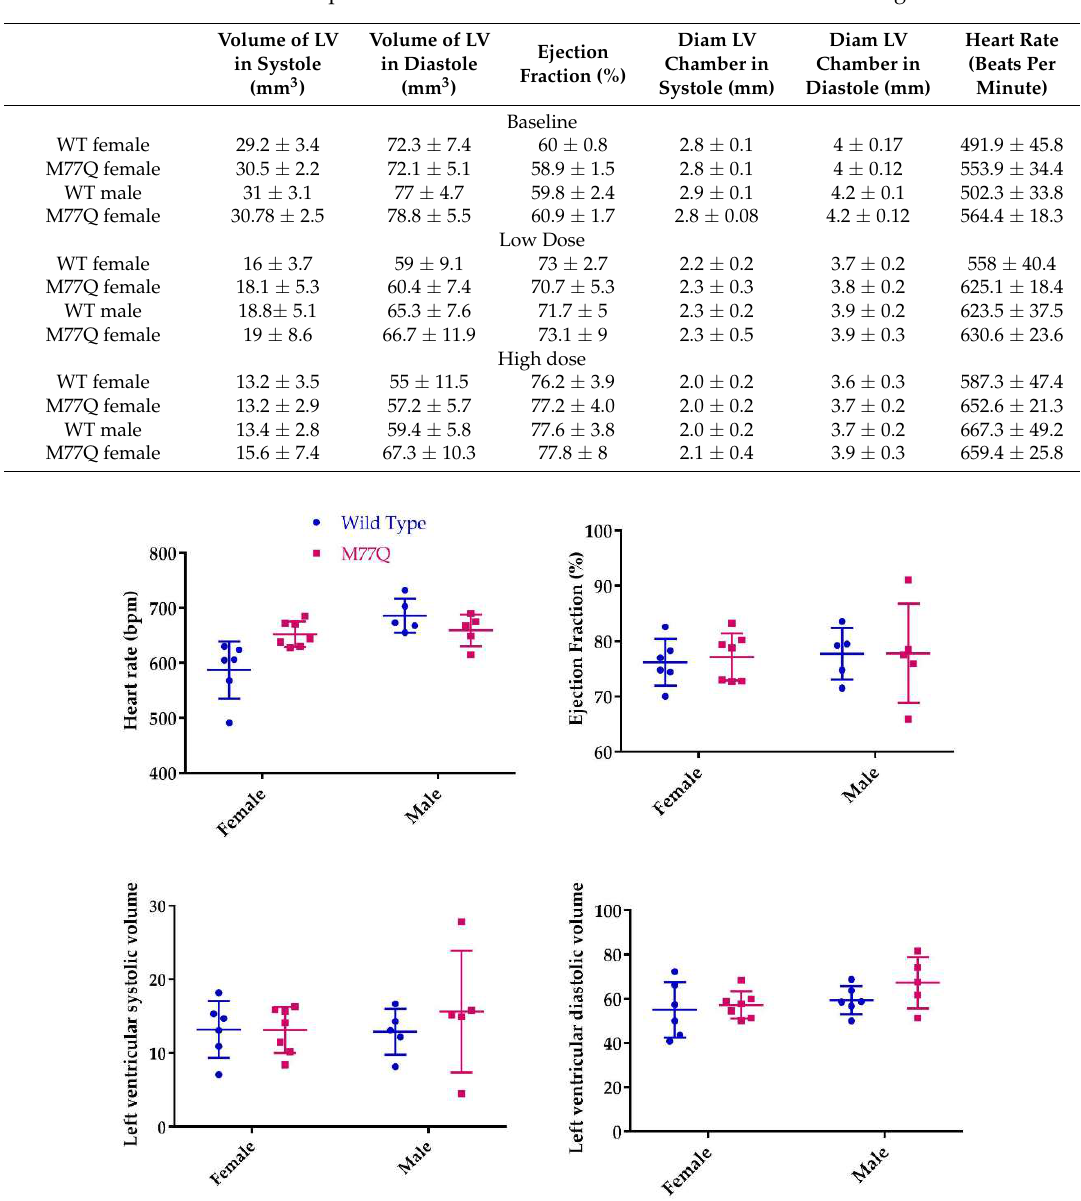
Table 1. Cardiac parameters from dobutamine stress tests at 6 months of age.